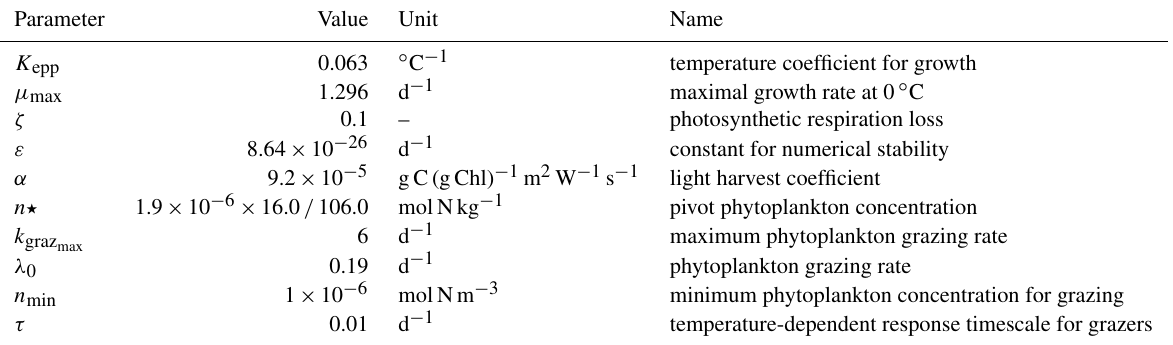
Table A1. Parameter values used in TOPAZv2 to compute the production and grazing of both small and large phytoplankton. Parameter Value Unit Name K epp 0.063